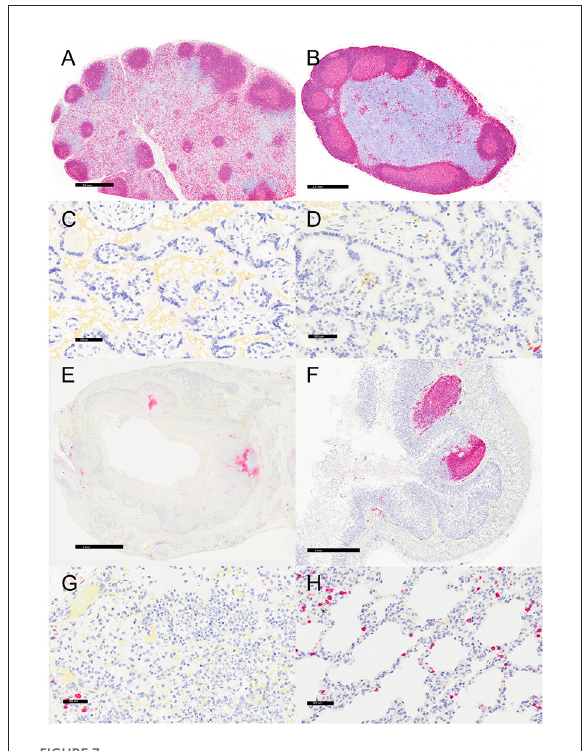
FIGURE7 Immunohistochemistry for CD20, vervets, multiple organs. (A) Y. enterocolitica- positive vervet, mesenteric lymph node, case 6. CD20-positive B cells are present in follicles and the medullary sinus. (B) Control vervet, mesenteric lymph node. CD20-positive cells are most prevalent in the cortical follicles. (C,D) CD20-positive cells are rare in the placenta from a Y. enterocolitica- positive vervet (C, case 20) and in the control vervet (D) . (E) Y. enterocolitica- positive vervet, colon, case 3. CD20-positive B cells are present in the colonic mucosa in areas of presumed gut-associated lymphoid tissue that are mostly effaced by necrosis and suppurative inflammation. (F) Control vervet, colon. CD20-positive B lymphocytes are abundant within gut-associated lymphoid tissue and rare in colonic mucosa. (G) Y. enterocolitica- positive vervet, lung, case 20. Few CD20-positive B cells lie adjacent to areas of necrosis. (H) Control vervet, lung. B cells are more prevalent and scattered throughout the alveolar walls of the control